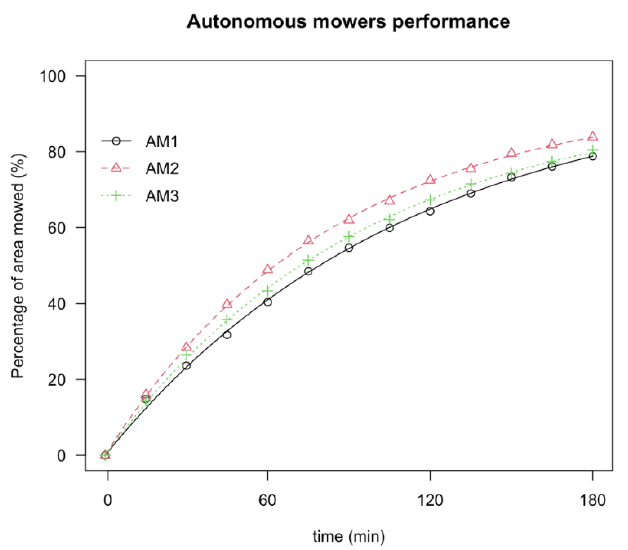
Figure 5. Percentages of area mowed as function of time (min) on the fitted asymptotic regression curves of each autonomous mower.